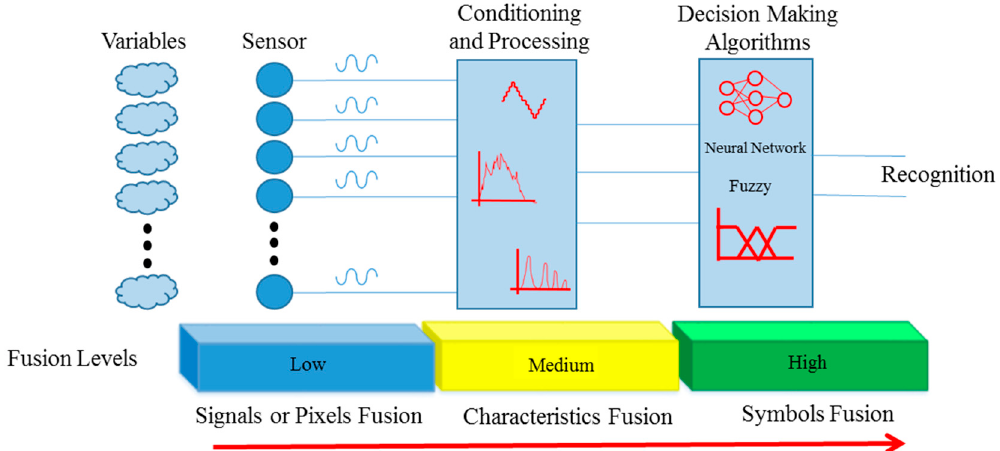
Figure 1. Summarized flowchart of a sensor fusion system.